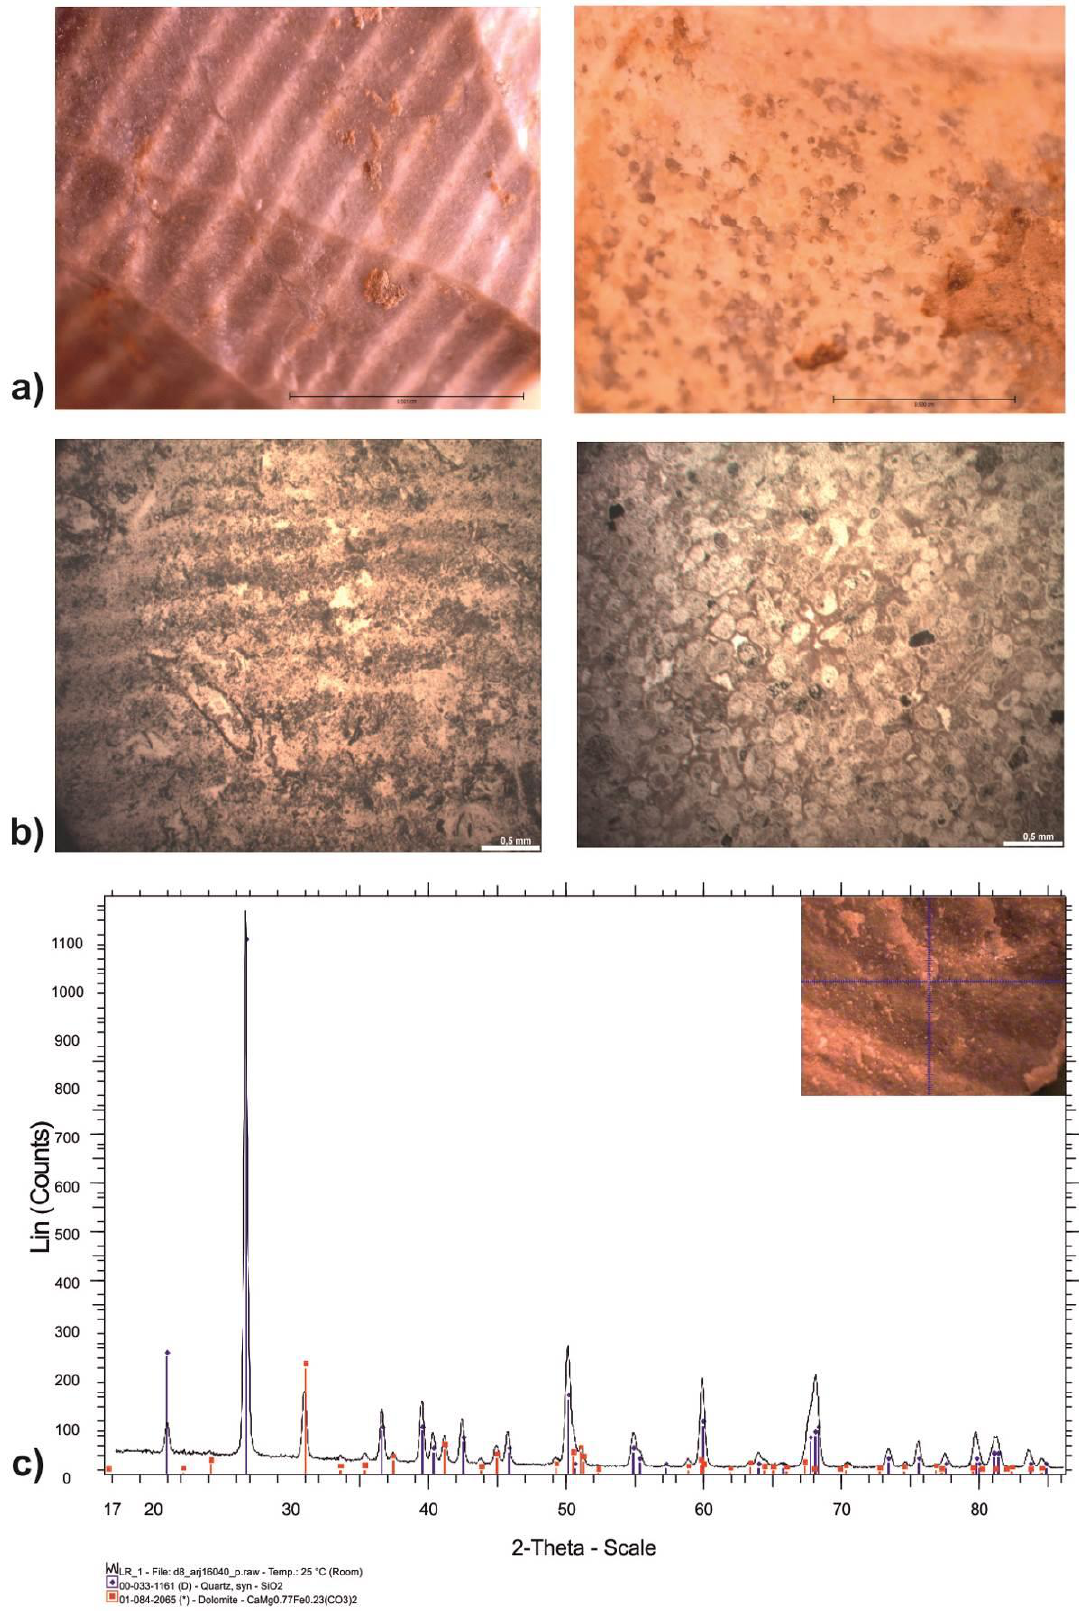
Figure 4. a) Macroscopical appearance of Muschelkalk chert samples with Liesengang rings (left) and microfossils (right). b) Thin section images with plane polariser showing lamination because of different silica- carbonates content (left) and packstone texture (right). c) μ-XRD of the indicated